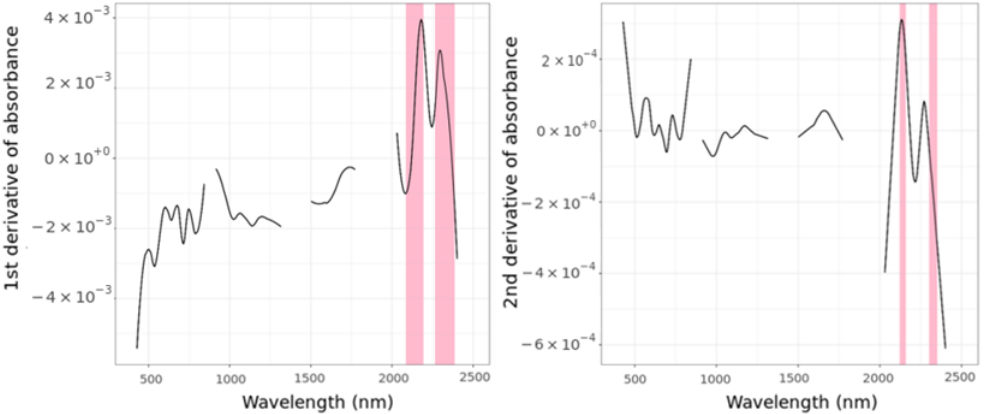
Figure 18. 1st and 2nd derivatives of a HySpex spectral signature with a high CaCO 3 content. The important spectral regions are highlighted in pink. The interval size varies according to the preprocessing method applied.